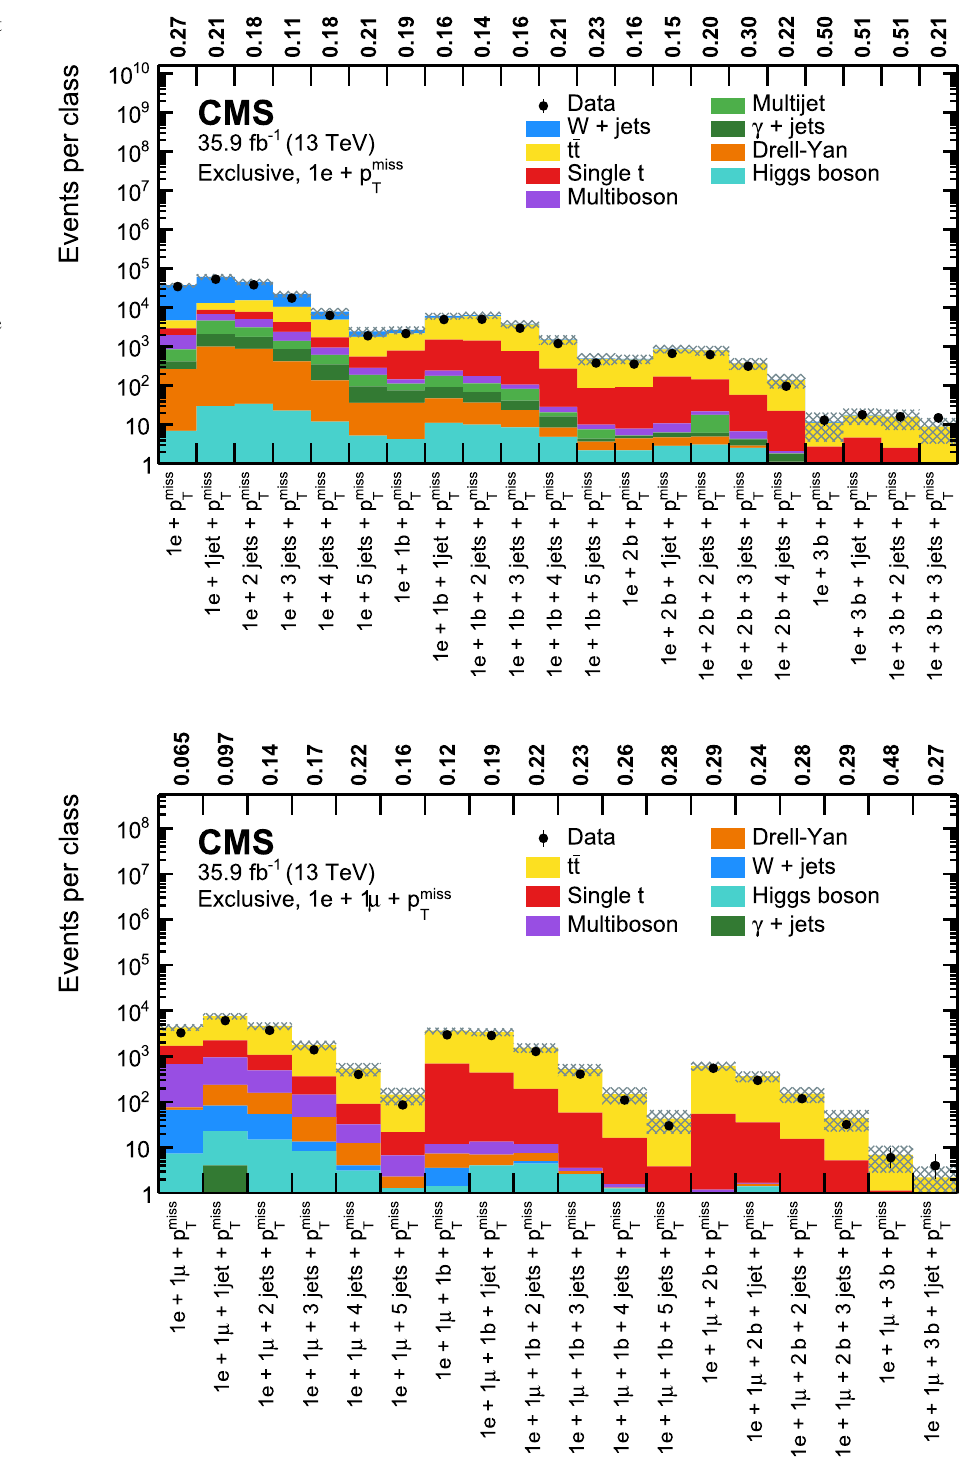
Fig. 16 Overview of total event yields for the event classes of the single-electron + p miss T (upper) and the single-electron + single-muon + p miss (lower) T object groups. Measured data are shown as black markers, contributions from SM processes are represented by coloured histograms, and the shaded region represents the uncertainty in the SM background. The numbers above the plot indicate the observed p value for the agreement of data and